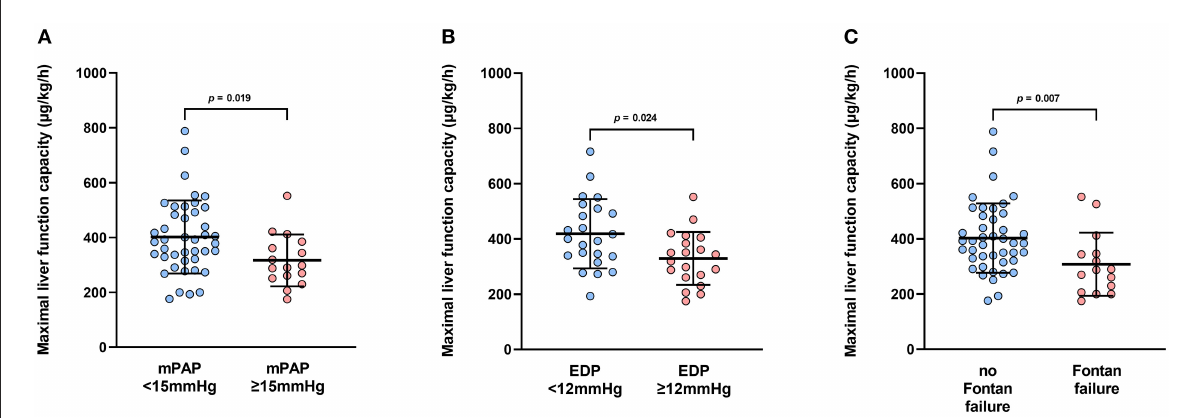
FIGURE1 (A) Boxplots depict maximal liver function capacity according to mean pulmonary artery pressure (mPAP). mPAP < 15 mmHg: n = 42; mPAP < 15mmHg: n = 15. (B) Boxplots depict maximal liver function capacity according to systemic ventricular end-diastolic pressure (SVEDP). SVEDP < 12mmHg: n = 23; SVEDP < 12mmHg: n = 19. (C) Boxplots depict maximum liver function capacity according to the presence of Fontan failure. Fontan failure; n = 15; no Fontan failure, n =